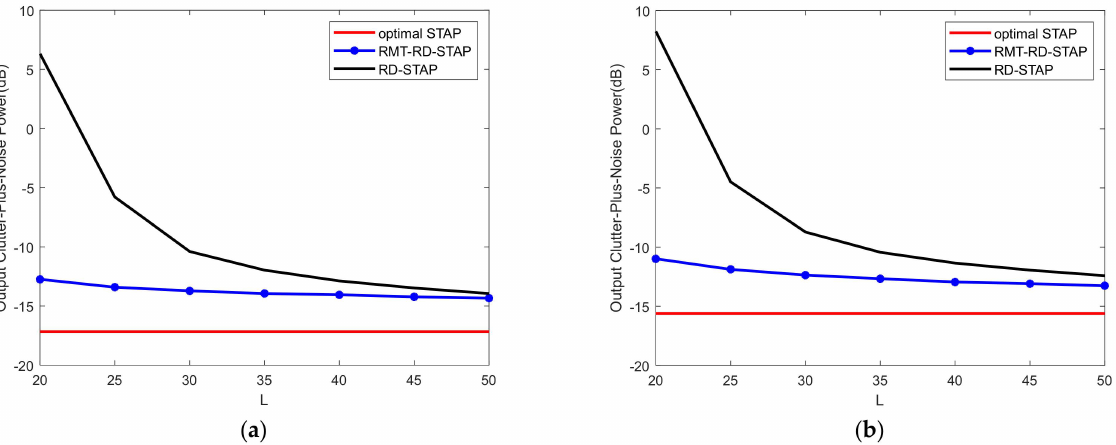
Figure 2. The output clutter-plus-noise power against the number L of the training samples. ( a ) V = 150 m/s and ( b ) V = 300